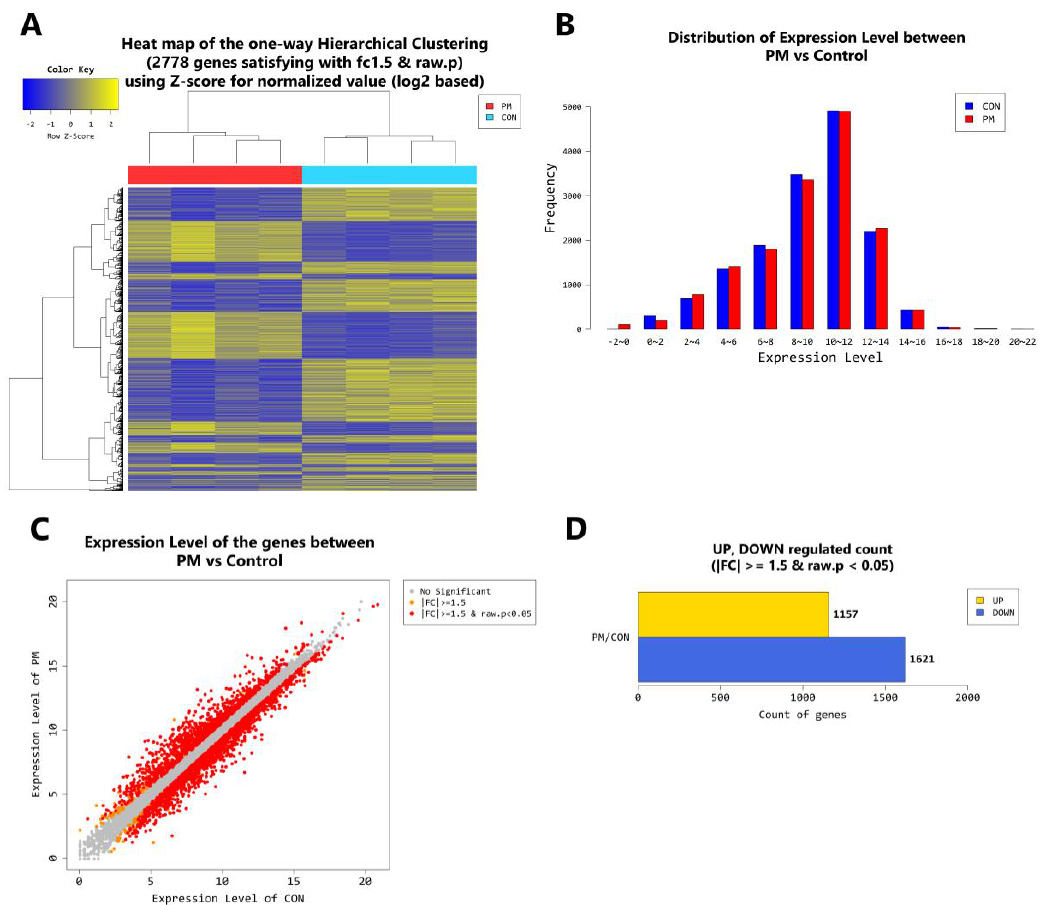
Figure 6. ( A ) Heat map of the one-way hierarchical clustering (PM young vs. control young). ( B ) Distribution of gene expression level between PM-exposed and control young dermal fibroblasts. ( C ) Scatter plot of gene expression level. ( D ) Significant gene count by fold change and p -value. n = 4 in each group (PM young, control young). Only those genes exhibiting log 2 fold change (FC) > 1.5 and p < 0.05 were considered as differentially expressed genes. For DEG (differentially expressed gene) set, hierarchical clustering analysis was done with complete linkage and Euclidean distance as a measure of similarity.